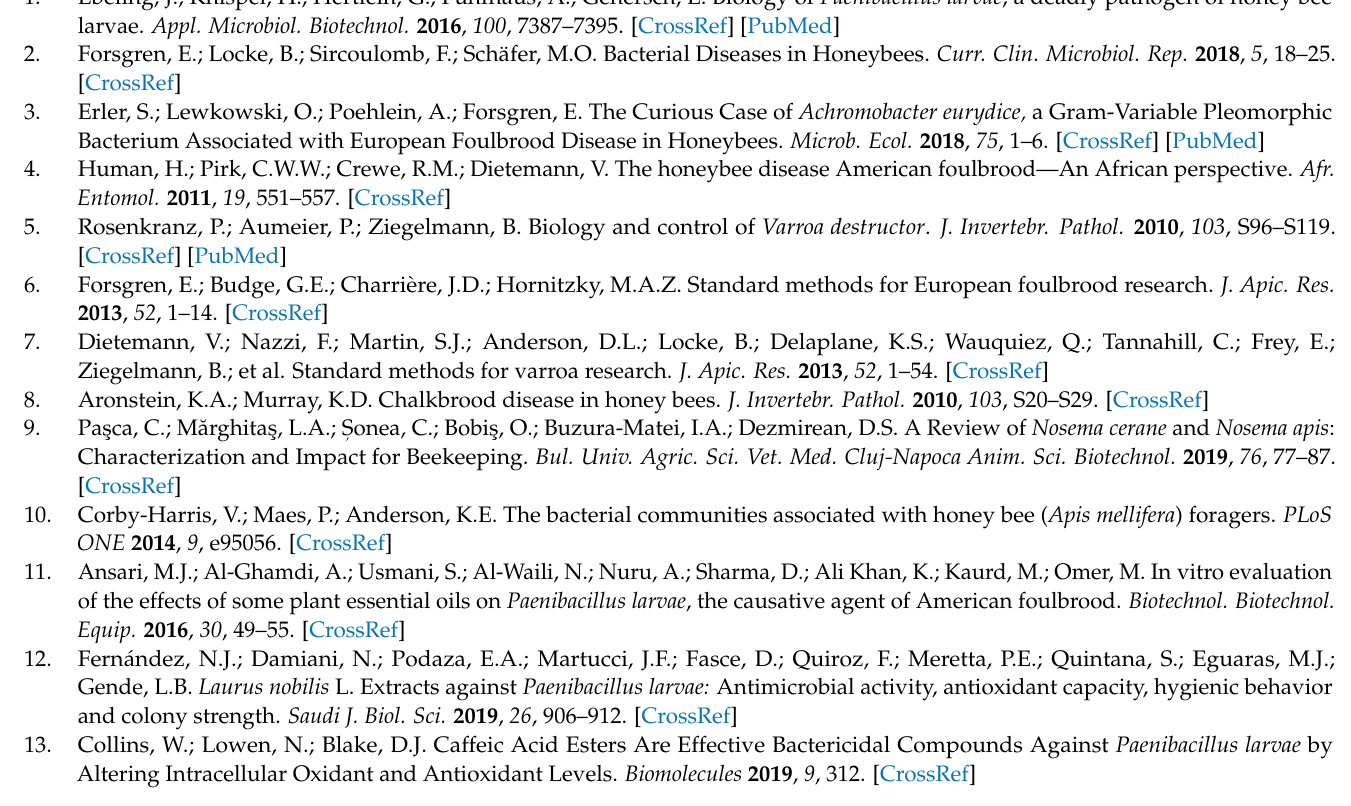
Table S2: Recipes of medicinal products (final volume 100 mL), Table S3: Microscopic analysis of N. ceranae- infected honey bees, Figure S1: Agarose gel electrophoresis of N. ceranae -specific PCR products, using spores extracted from “R2” lot samples, Figure S2: Agarose gel electrophoresis of N. ceranae -specific PCR products, using spores extracted from “honey” lot